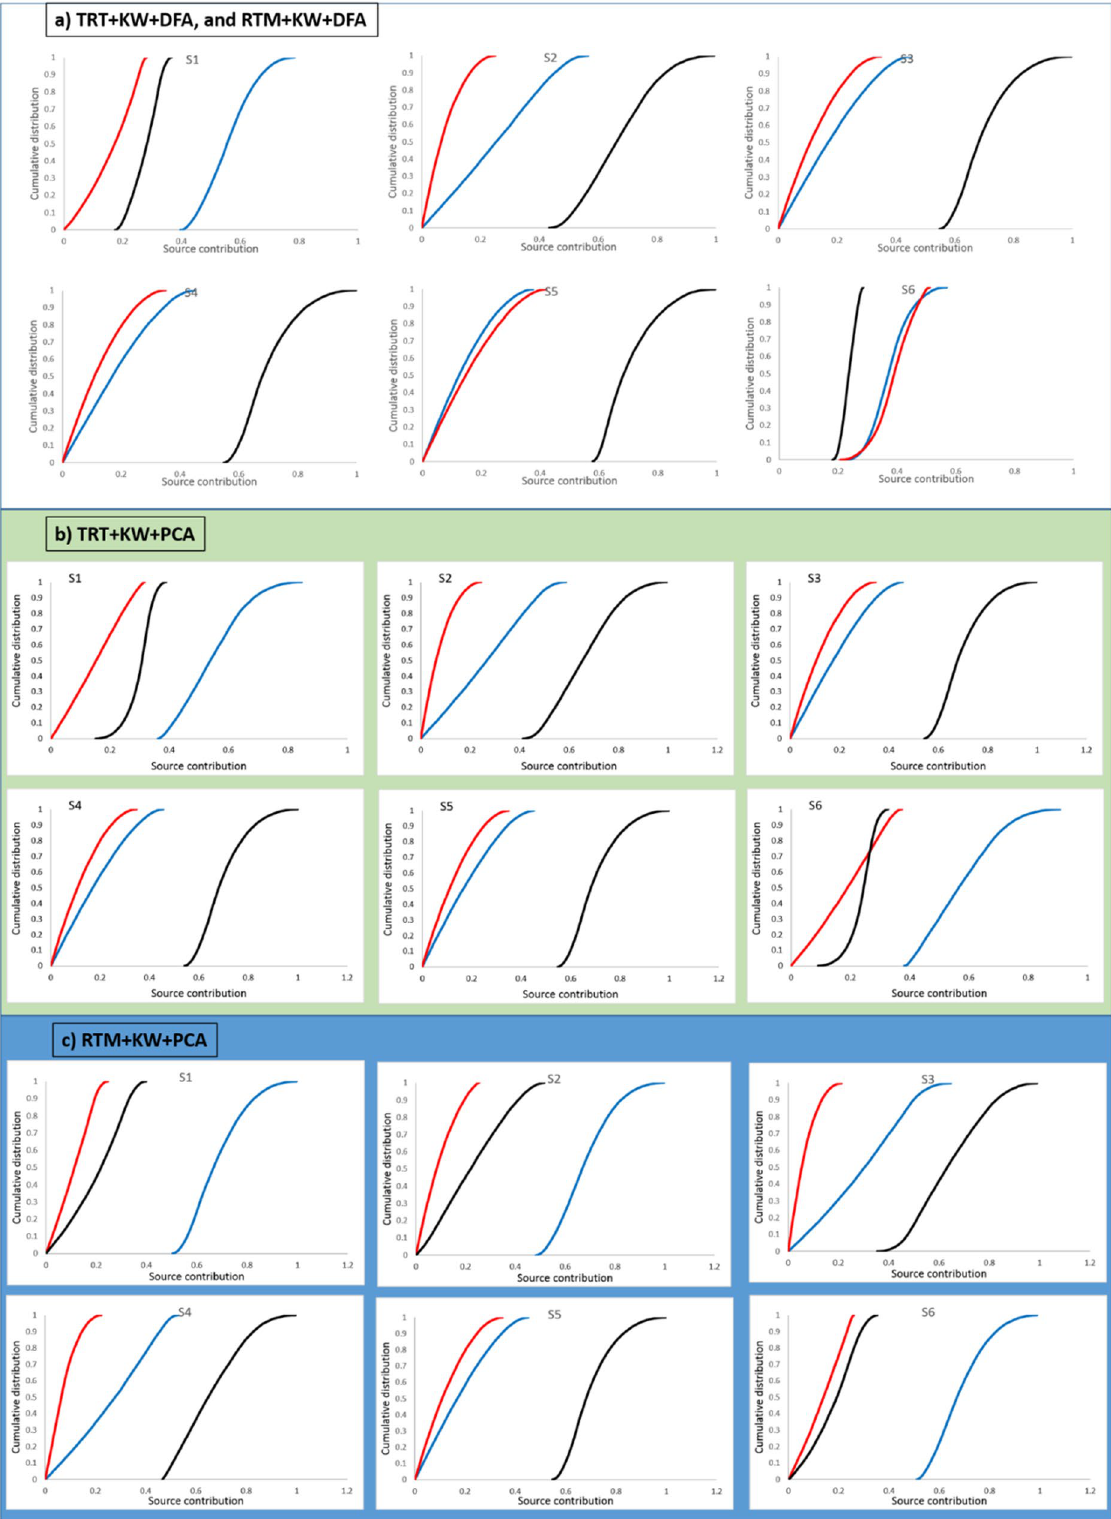
Figure 8. The cumulative distributions for the predicted contributions from the three sub-basin spatial sources (western sub-basin—blue line; central sub-basin—red line, and; eastern sub-basin—black line) modelled using GLUE based on the final composite signatures selected using the four different combinations of statistical